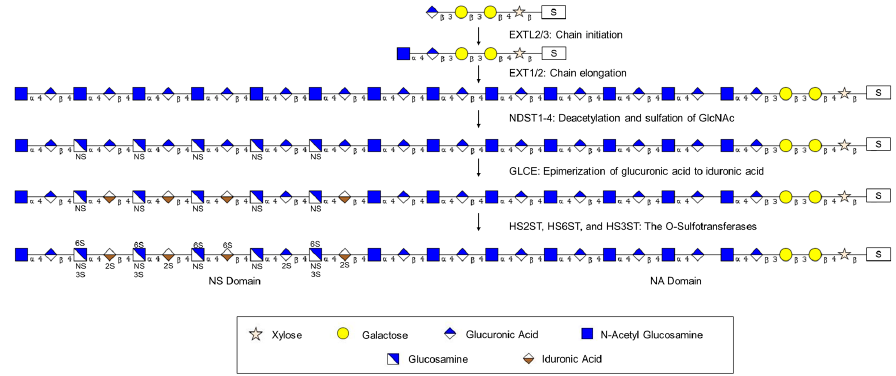
Figure 3. Initially, the EXT (exostosin) family of enzymes are responsible for heparan sulfate (HS) chain initiation and elongation from the serine residue (S) on a core protein. Deacetylation and sulfation of HS is performed by the NDST ( N -deacetylase/ N -sulfotransferase) family of enzymes. Enzymatic activity of GLCE ( D -glucuronyl C5-epimerase) results in epimerization of glucuronic acid to iduronic acid on the HS chain. Finally, the HSxST family of enzymes (heparan sulfate O -sulfotransferases; x = 2, 3, or 6) catalyzes additional sulfation of the HS chain on C2, C3, and C6, respectively, within the NS domains.